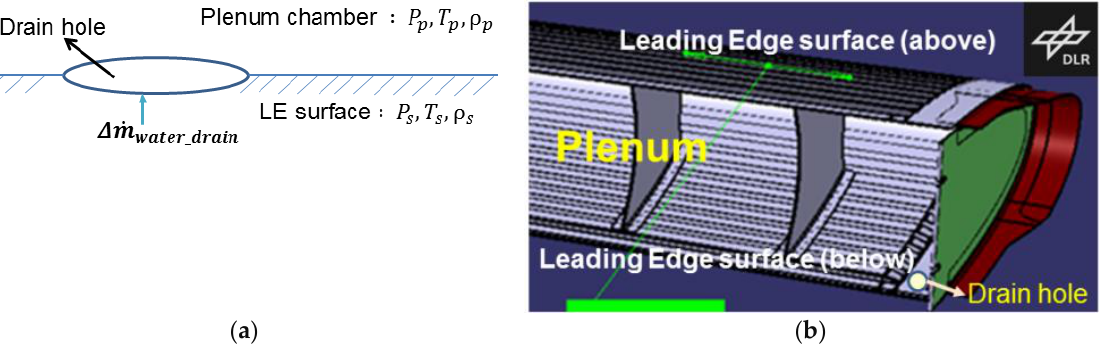
Figure 17. Plenum with drain hole: ( a ) Schematic with parameters; ( b ) graphical representation.